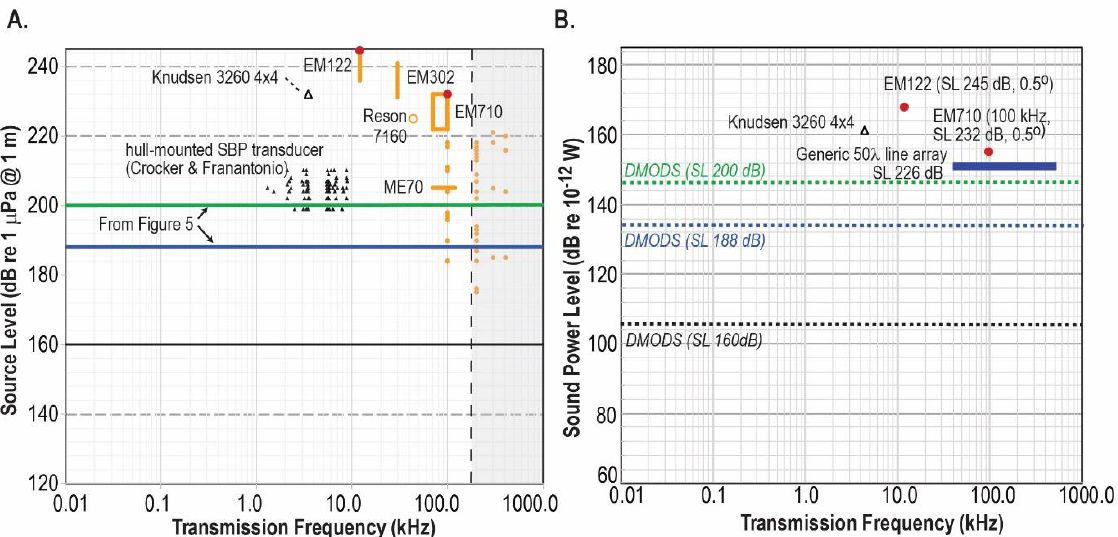
Figure 8. ( A ) Data from Figure 4 for two directional sources (a variety of multibeam echosounders in orange and hull-mounted subbottom profilers in black), along with Factors 1 (gray box) and 2 (green and blue lines) from Figure 5. Black line denotes 160 dB threshold. Knudsen 4 × 4 refers to a 16-transducer system with 4 transducers on a side. Red circles correspond to MBES configurations used for calculations in panel ( B ). ( B ) Sound power level (Factor 3) calculated for Knudsen 4 × 4 and red circle MBES directional sources shown in ( A ). For comparison, the calculation for a line array with SL of 226 dB re 1 μPa @ 1 m is shown in blue. Also shown are the sound power levels determined for de minimis omnidirectional sources (DMODS) with SL of 200 (green), 188 (blue), and 160 (black) dB re 1 μPa @ 1 m (from Figure 5) radiating into a hemisphere.